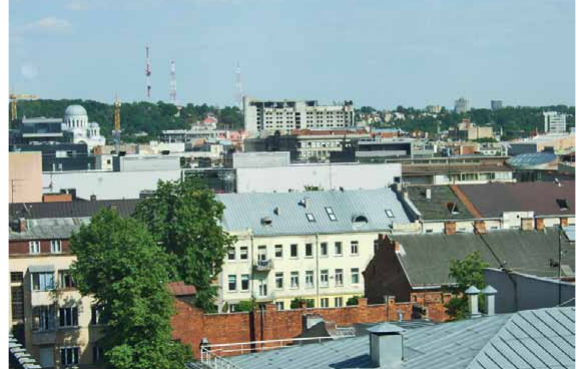
fig. 6. Discordant shapes in Kaunas naujamiestis